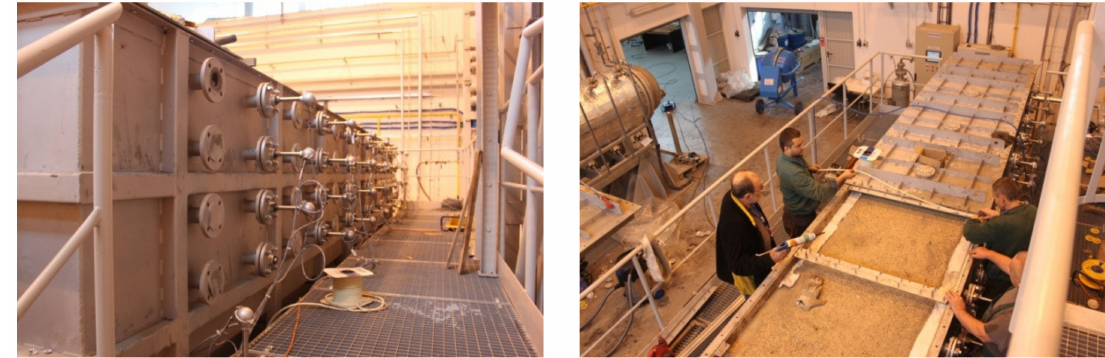
Figure 2. Ex situ UCG installation used in the study.